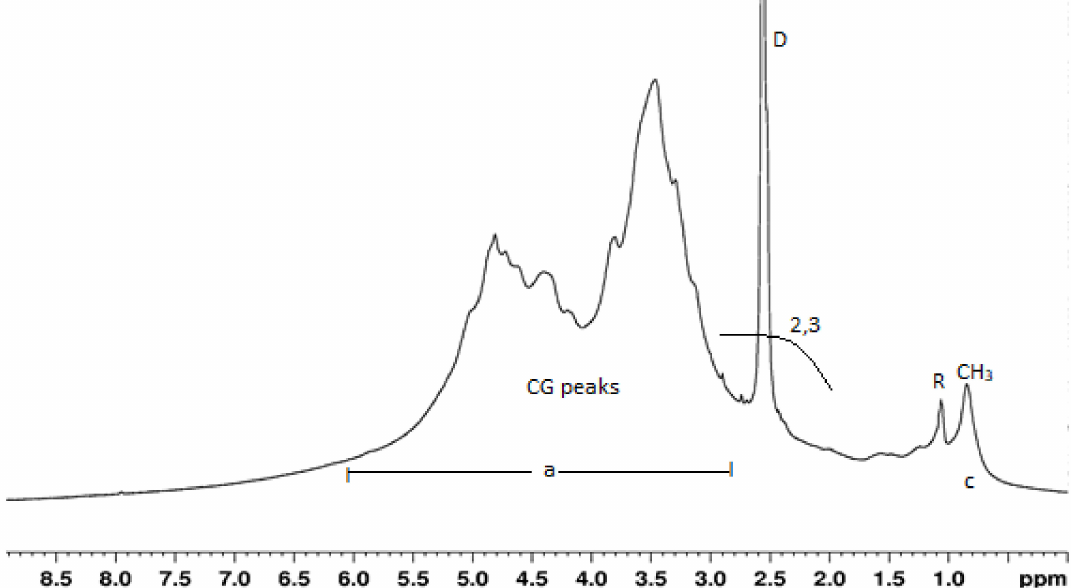
Figure 2. 1 H NMR spectrum of a CG–TPSA adduct in d 6 -DMSO. The proton numbers for succinate follow the scheme shown in Scheme 1; D = DMSO; R = methyl from